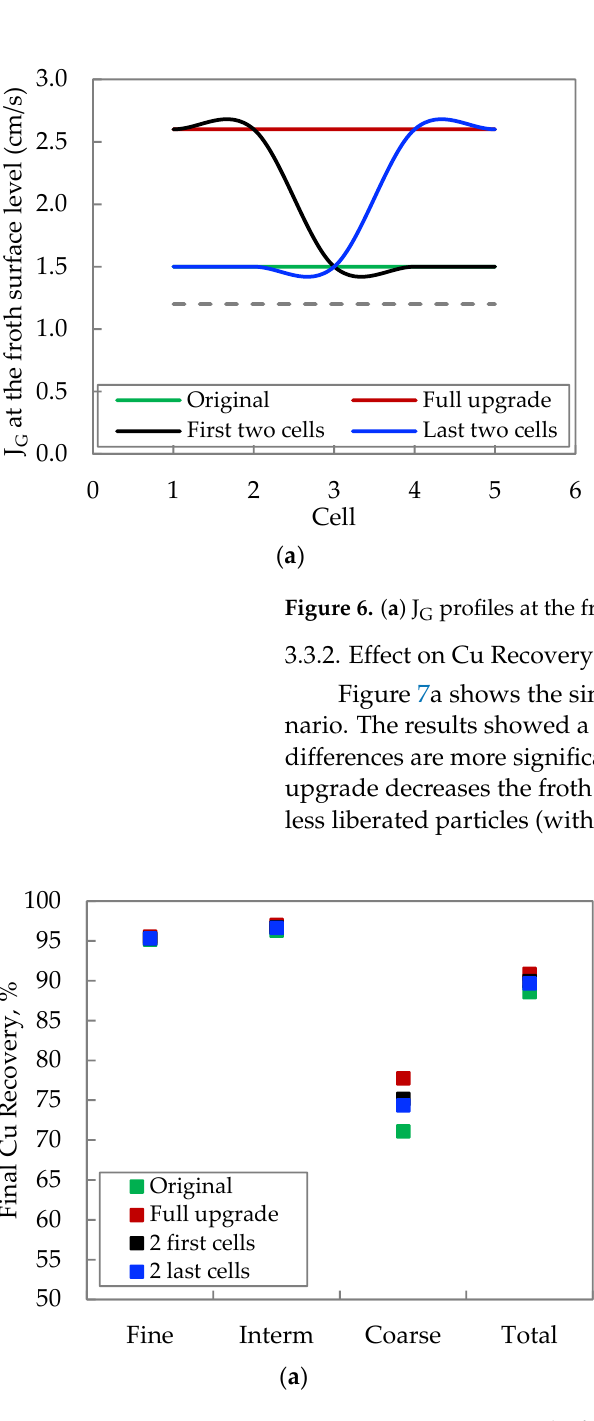
Figure 7. Cu recovery results for the four scenarios: ( a ) Final Cu recovery per particle size class and ( b ) recovery profiles for coarse particles (+106 µm).